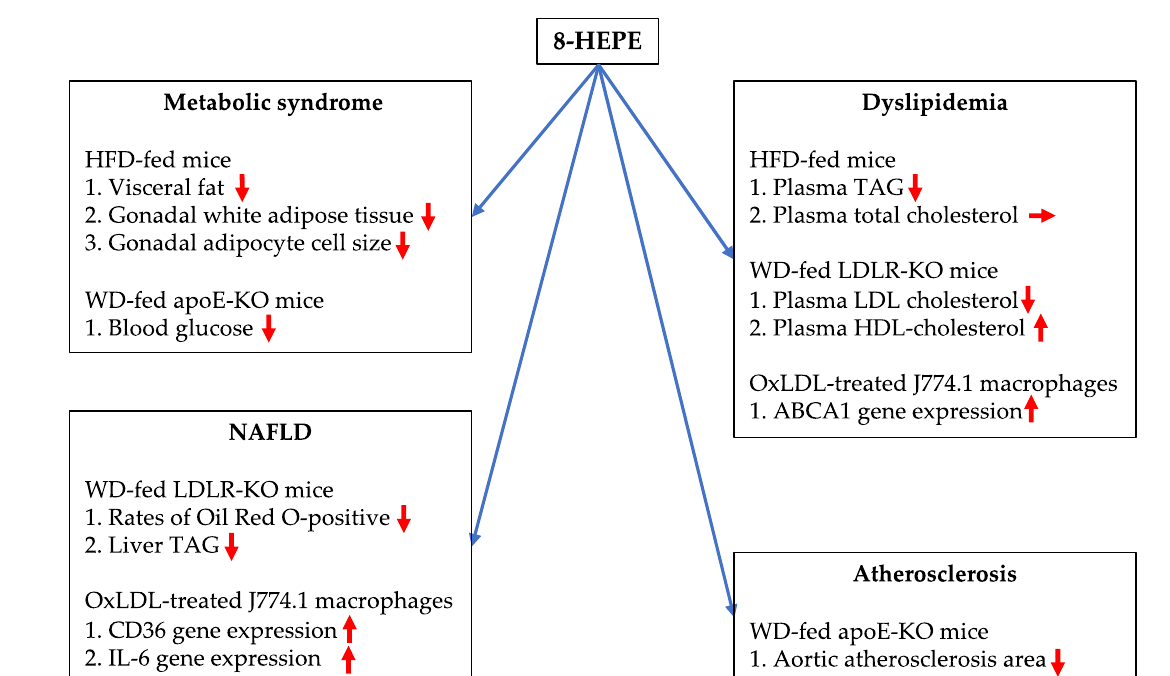
Figure 4. Potential beneficial effects of 8-HEPE against metabolic syndrome, dyslipidemia, NAFLD, and atherosclerosis. HFD, high-fat diet; WD, Western diet; apoE-KO, apolipoprotein E knock out; LDLR-KO, low-density lipoprotein receptor knock out; TAG, triacylglycerol; IL-6, interleukin 6; OxLDL, oxidized LDL; ABCA1, ATP-binding cassette transporter 1.